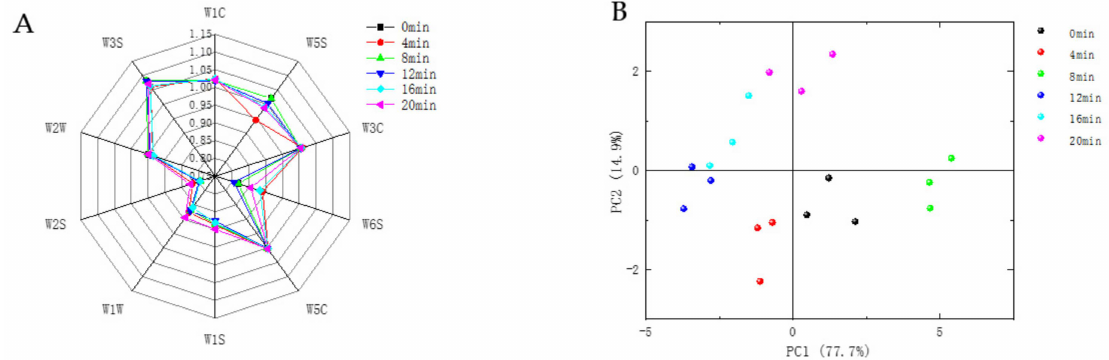
Figure 4. Radar diagram ( A ) and PCA ( B ) of defatted tiger nut flour for E-nose.